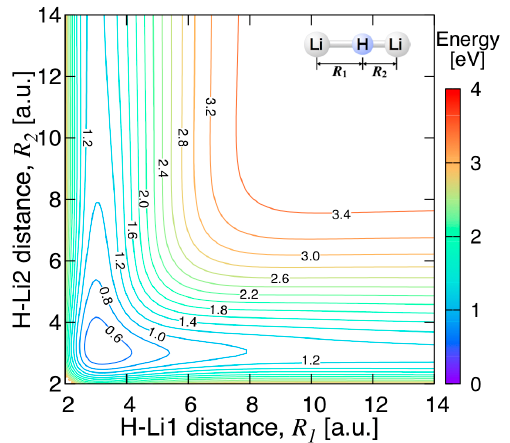
Figure 9. Energy contours for the Li − H − Li linear configuration. The energy contours are equally spaced by 0.2 eV, starting at the ground state